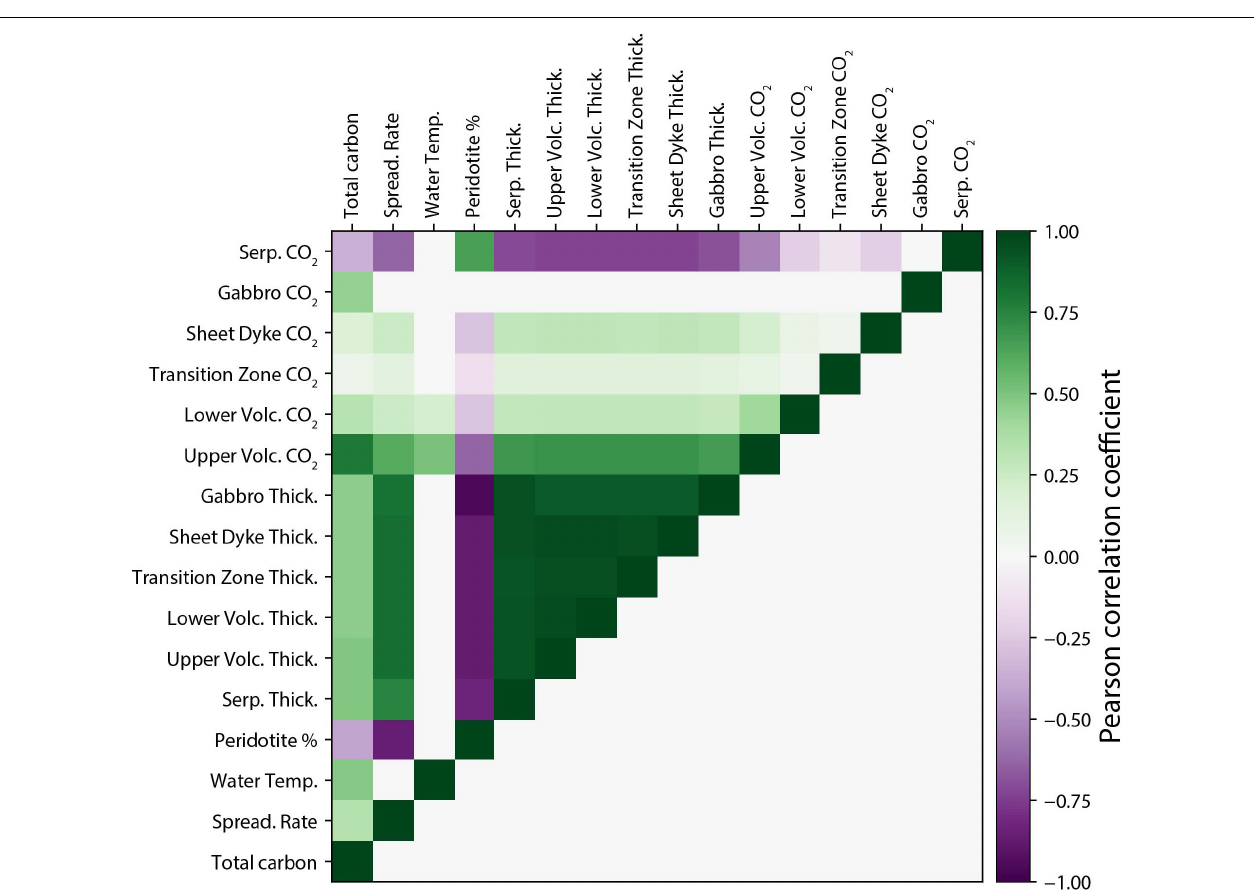
Table 1 details which parameter values are chosen by random sampling, the distributions from which they are drawn, and the dependency of each parameter on other randomly sampled parameters. The Pearson correlation coefficient of each parameter is presented in Figure 4 . Peridotite percent is negatively correlated with the thickness of other rock types, as